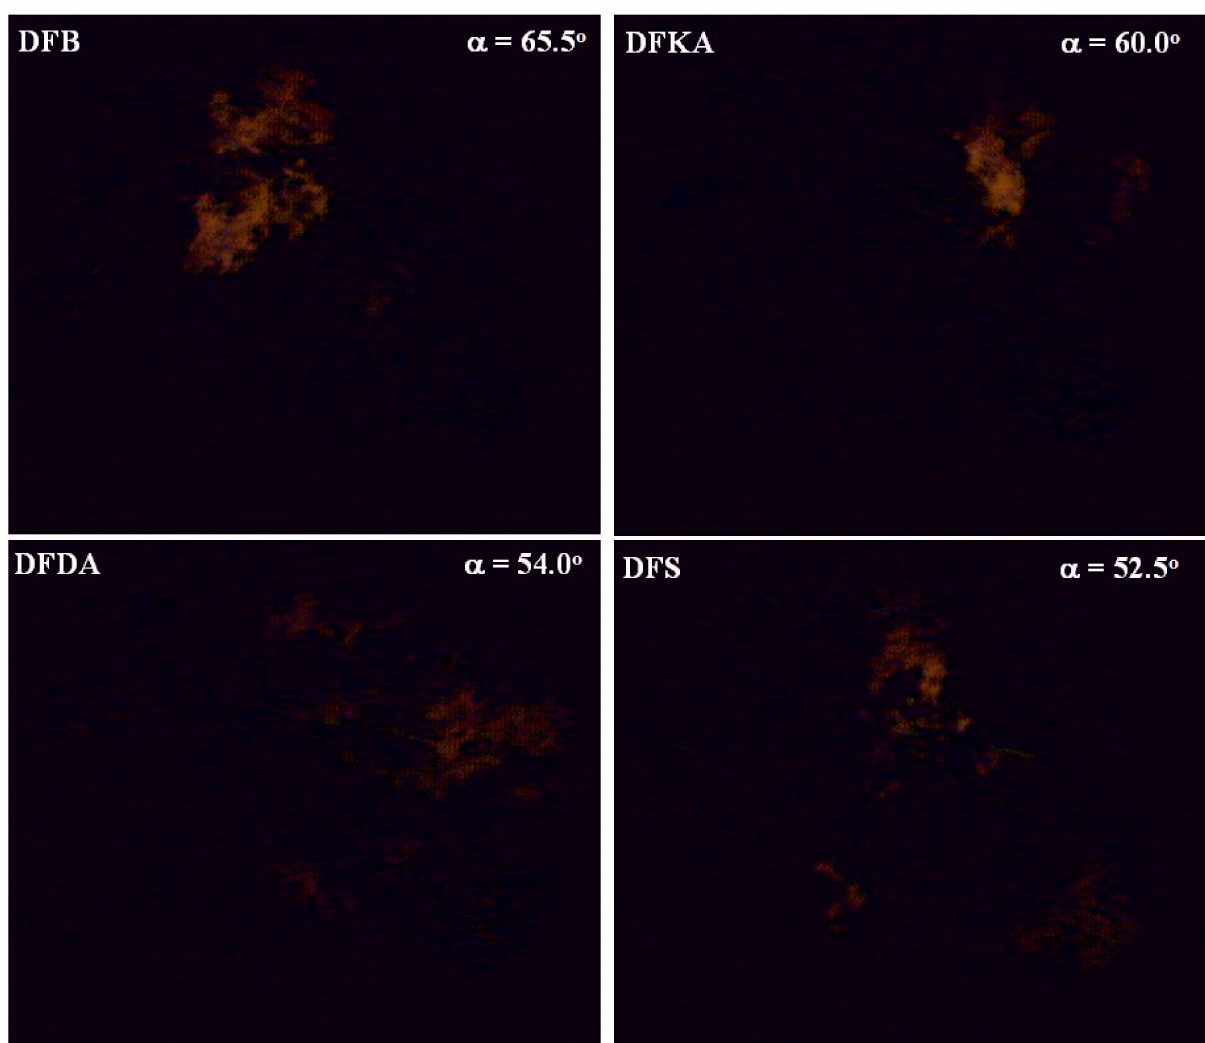
Figure 34. Image inside engine cylinder for crankshaft angle of rotation corresponding to visual end of combustion for tested fuels α EC